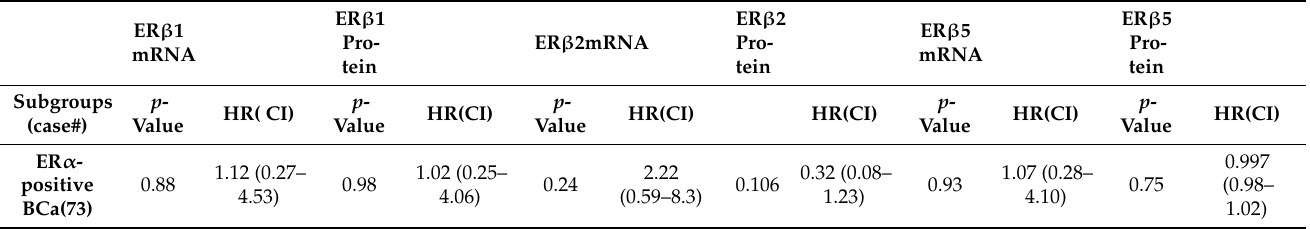
Table 5. Cox univariate analysis of ER β Isoform expression and overall survival in breast cancer subtypes and subgroups and in the entire